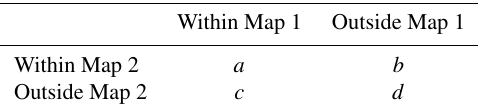
Table 1. Contingency table for the pairwise model agreement eval- uation as given by Eq. (2). The variables a , b , c , and d relate to the number of pixels within each river basin.